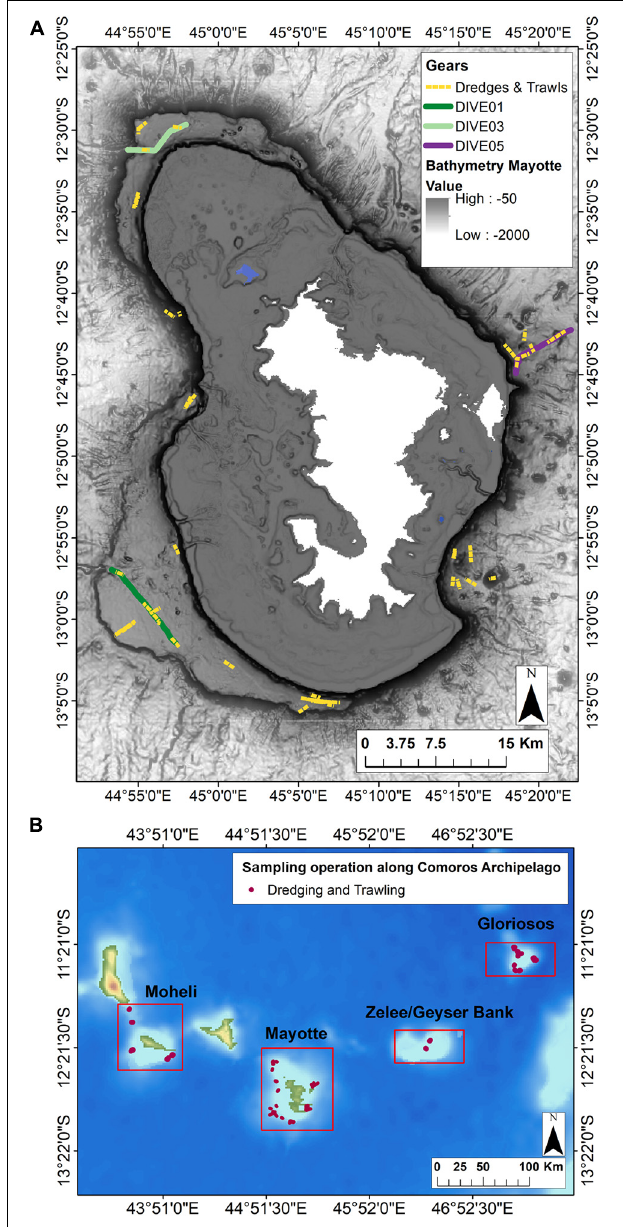
FIGURE 2 | (A) Location of the camera transects and dredge/trawl transects operations (dive, sampling along dive and in the surrounding area) undertaken along the outer slopes of Mayotte. (B) Location of the sampling in the surrounding area undertaken in the Comores Archipelago (Moheli, Geyzer Bank, Gloriosos). Solid lines represent camera transects and yellow dotted lines represent dredging (DW) and trawling (CP) operations.